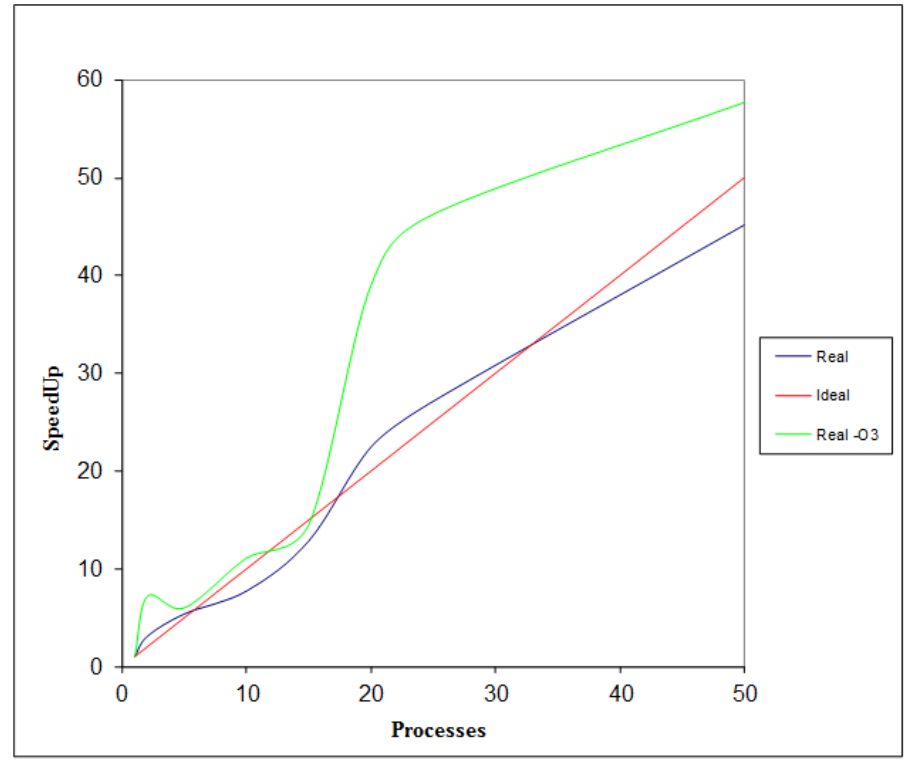
Figure 11. Speedup of the GGA in the Autonomous University of Morelos State (UAEM) cluster.